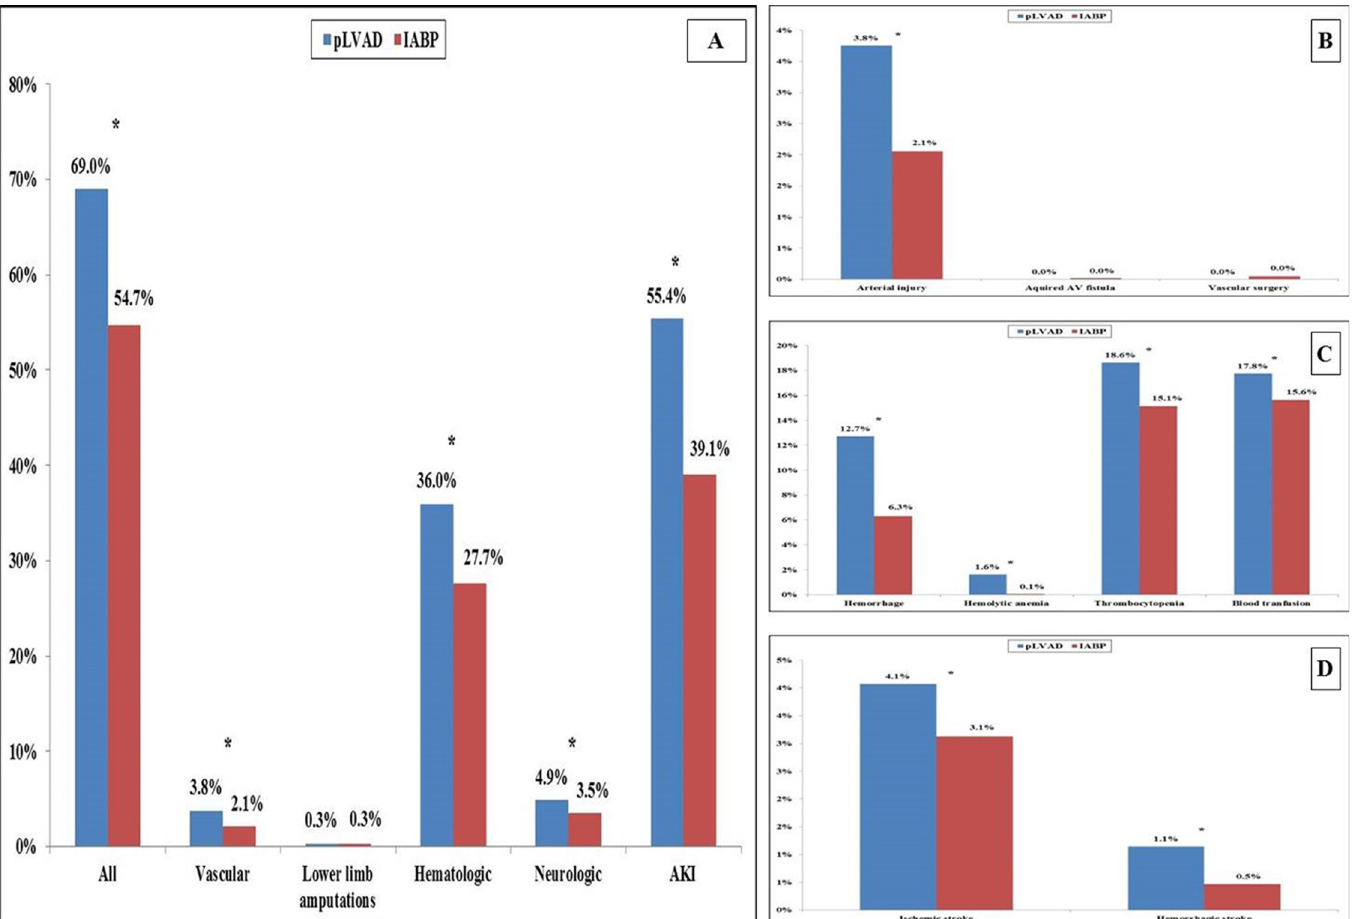
Fig 2. Complications in admissions receiving pLVAD and IABP support for AMI-CS. Legend: Cumulative complication rates (A) and individual components of vascular complications (B), hematologic complications (C) and neurologic complications (D); � p < 0.05. Abbreviations: AKI: acute kidney injury; AV: arterio-venous; IABP: intra-aortic balloon pump; pLVAD: percutaneous left ventricular assist device.